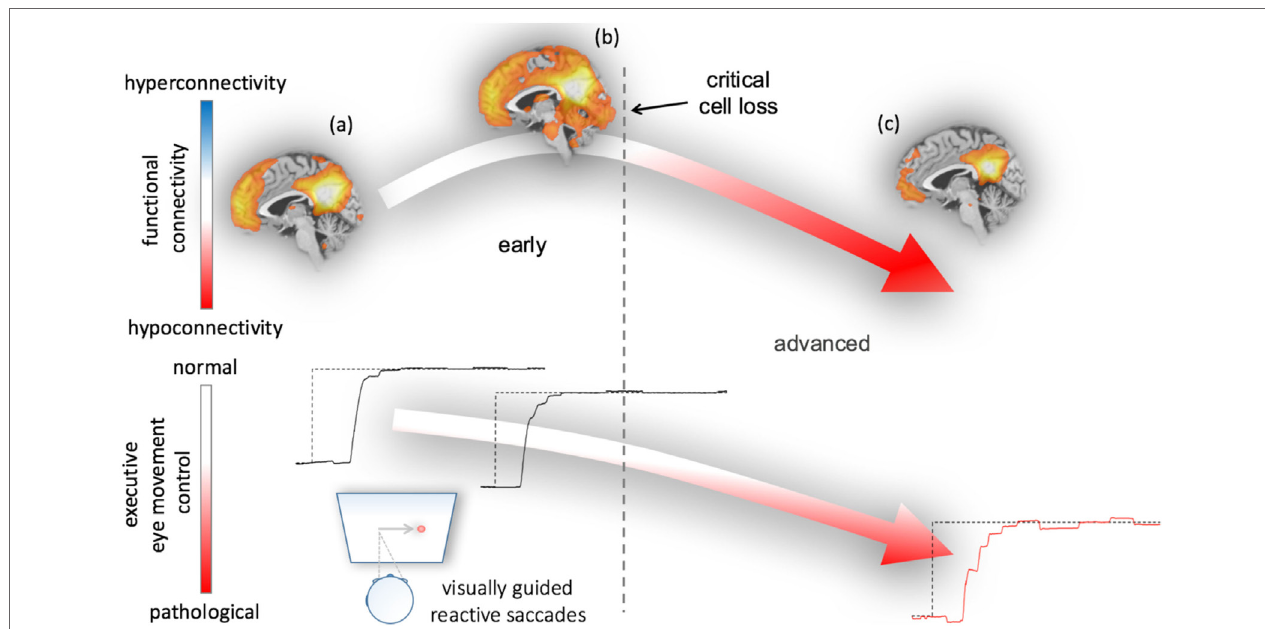
FiGURe 3 | Hypothetical model of functional connectivity alterations in association with executive eye movement control in Parkinson’s disease (PD). The model results from correlations between functional connectivity data and eye movement impairment in early and advanced patients with PD (63). Neural damage due to the ongoing PD-associated pathological process from (A) healthy or premotor to (B) clinically manifest disease status paradoxically results in increased functionally connectivity early in the course of the disease upon a critical cell loss is reached. During this phase, executive oculomotor function gradually worsens as evidenced from visually guided reactive saccade performance (lower row)—remarkably, neuropsychological assessment in these patients revealed cognitively unimpaired “normal” performance (67). (C) In the final stages of PD, patients most patients met the criteria of PD-associated dementia and have developed a function disconnection syndrome (decreased functional connectivity) that is associated with a pattern of severely impaired eye movement control (right lower